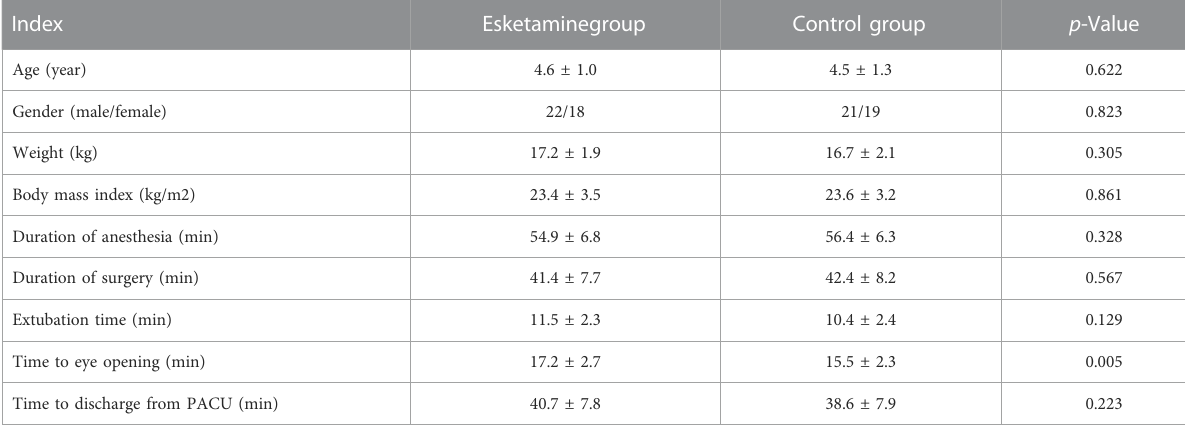
TABLE 1 Data of children ( n = 40).